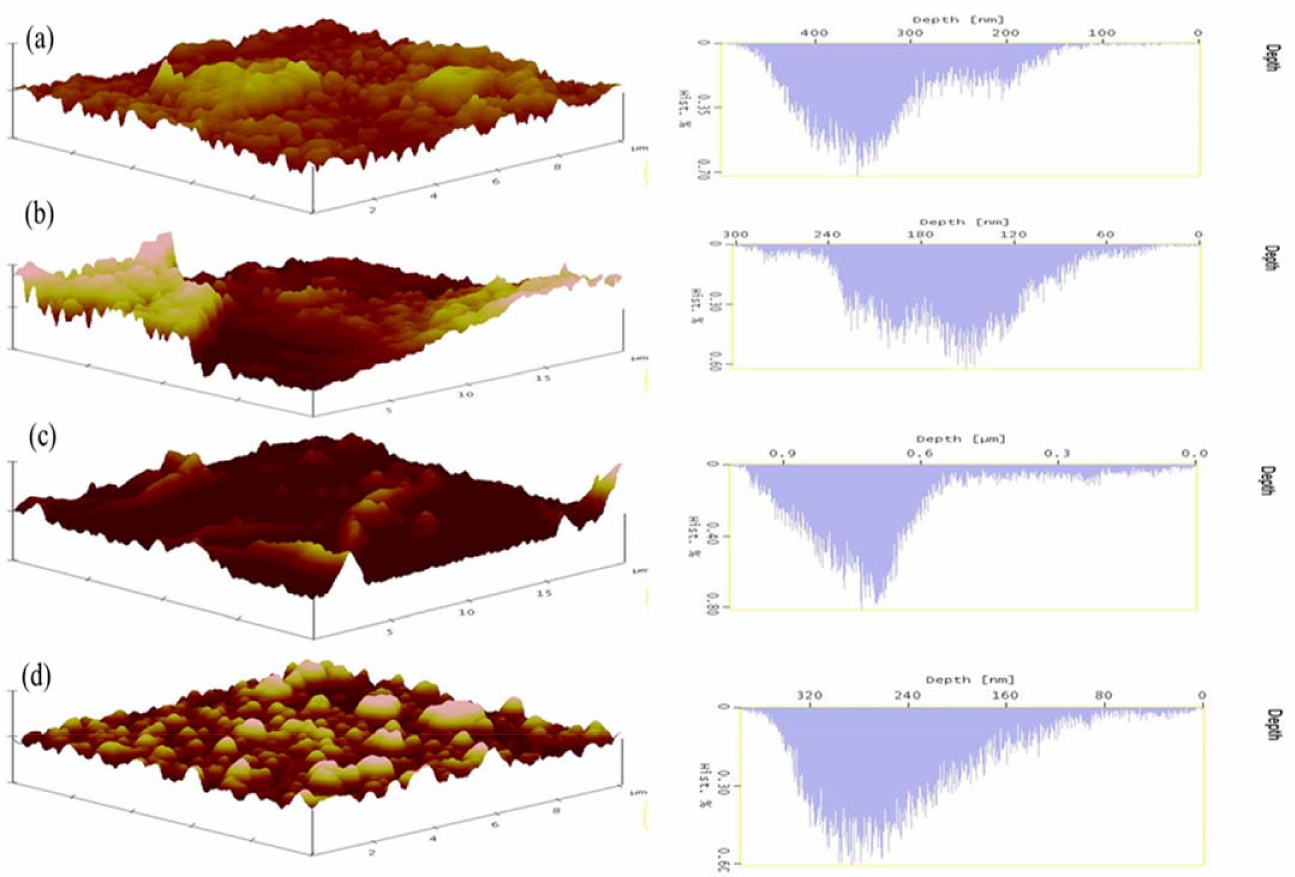
Figure A1. AFM images of PA–TFC membranes modified with; ( a ) 1.00:1.00% ZnO/AA, ( b ) 1.50:1.00% ZnO/AA, ( c ) 1.00:1.50% ZnO/AA, ( d ) 1.50:1.50%